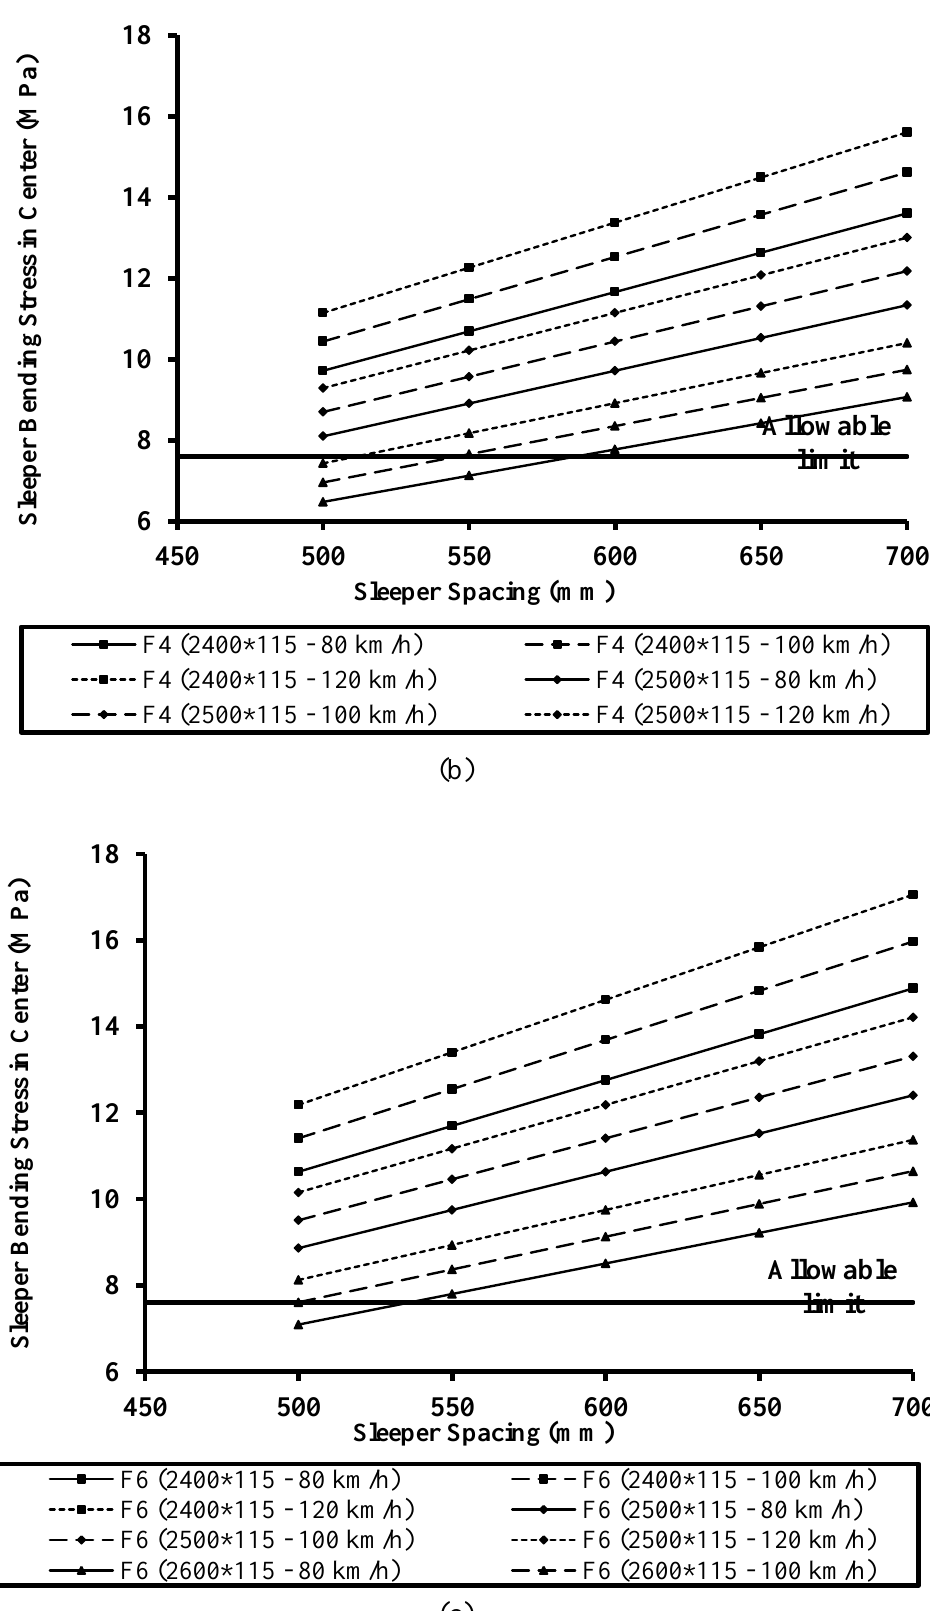
Fig. 10. Variations in the sleeper bending stress at the center of the sleeper under loading for a) passenger train, b) 4- axles freight train, c) 6- axles freight